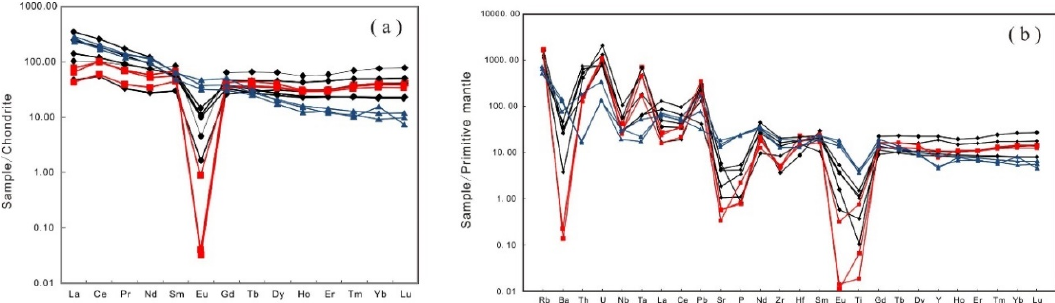
Figure 8. ( a ) Chondrite-normalized rare earth element (REE) patterns of main-phase granites, granite porphyry, and mafic dykes of Qianlishan and ( b ) primitive mantle-normalized trace element diagrams for main-phase granites, granite porphyry, and mafic dykes of Qianlishan (main-phase granites in black, granite porphyry in red, and mafic dykes in blue): the values of chondrite and primitive mantle are from [60].